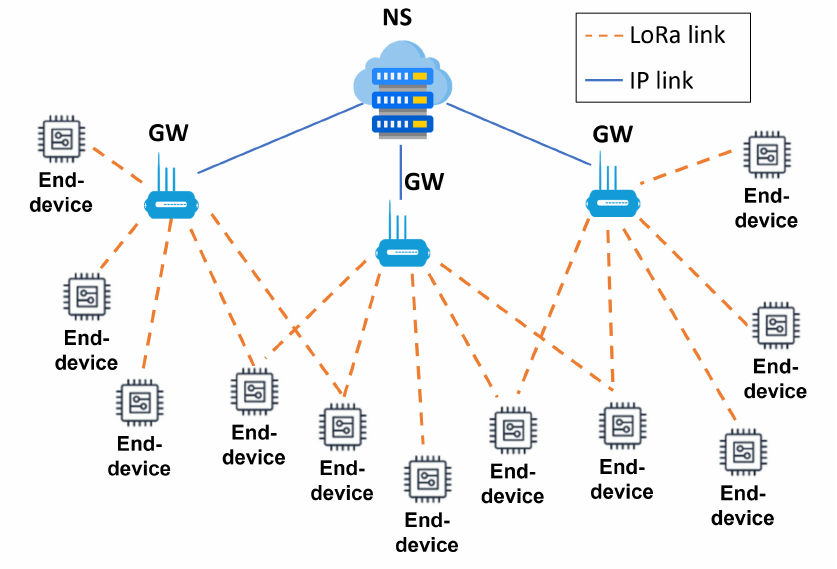
Figure 1. The LoRaWAN